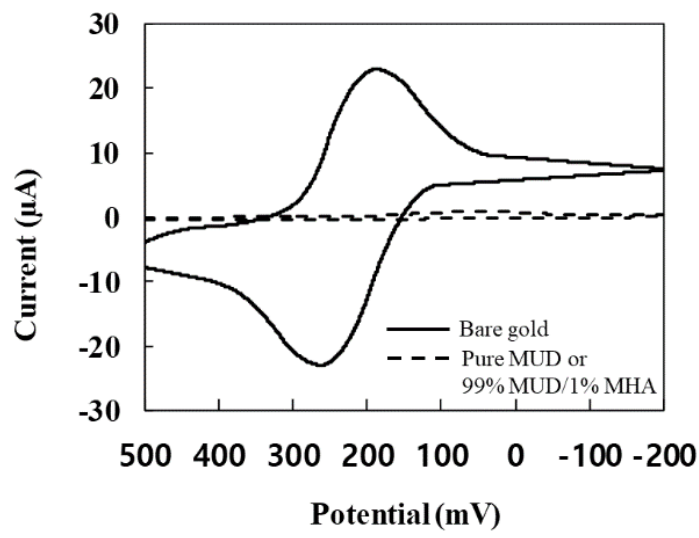
Figure 2. CV response after the monolayer formation on the gold electrode.